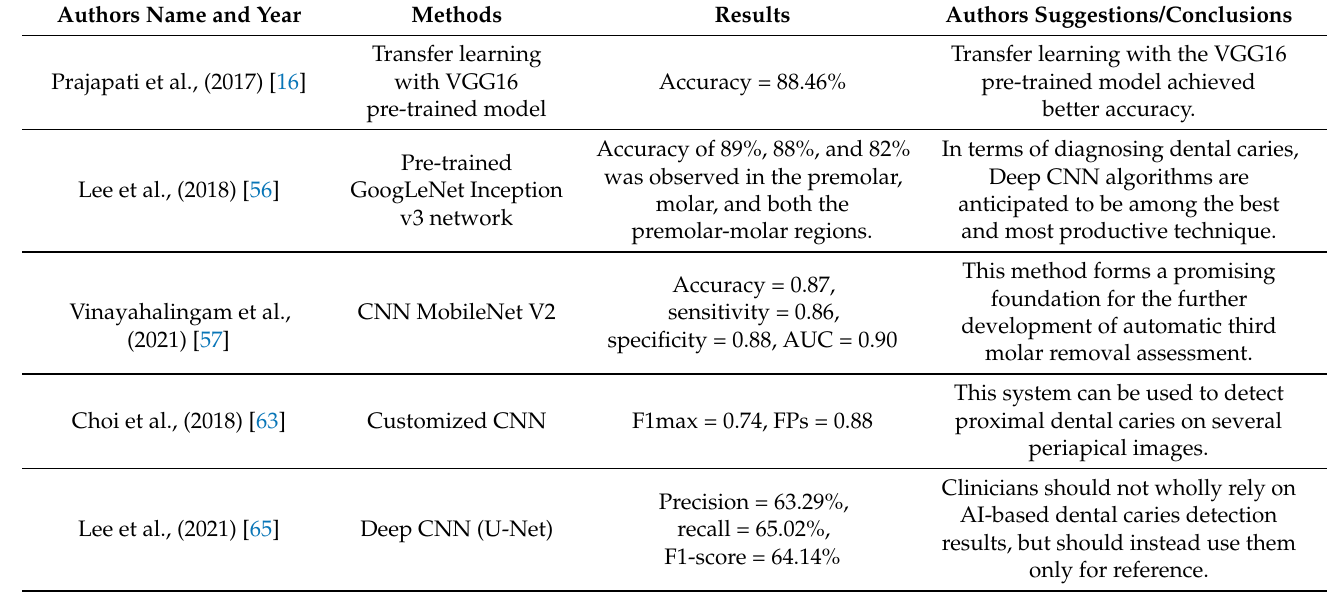
Table 5. CNN selected